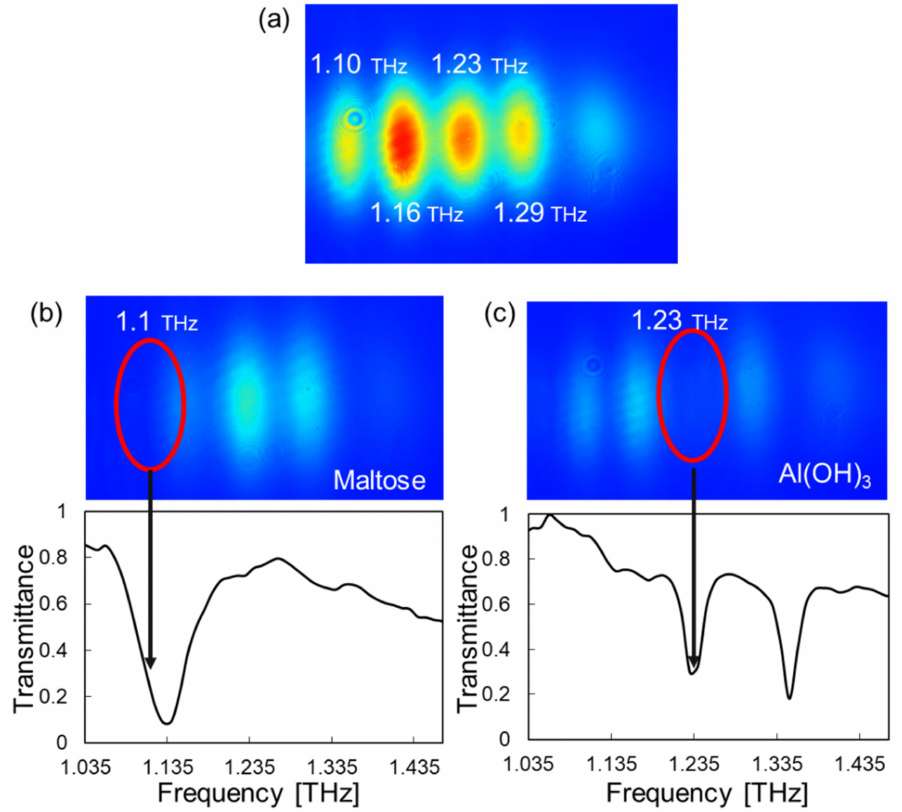
Figure 9. Reagent spectral results. ( a ) Reference with no sample inserted (output flattened by filter) ( b ) One-shot spectra of maltose and ( c ) Al(OH) 3 and their reference